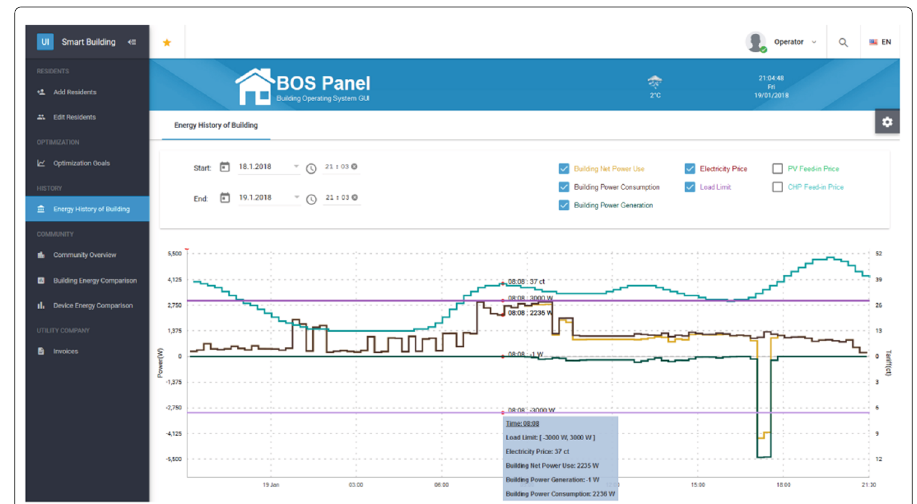
Fig. 12 BOS UI: the energy history of the